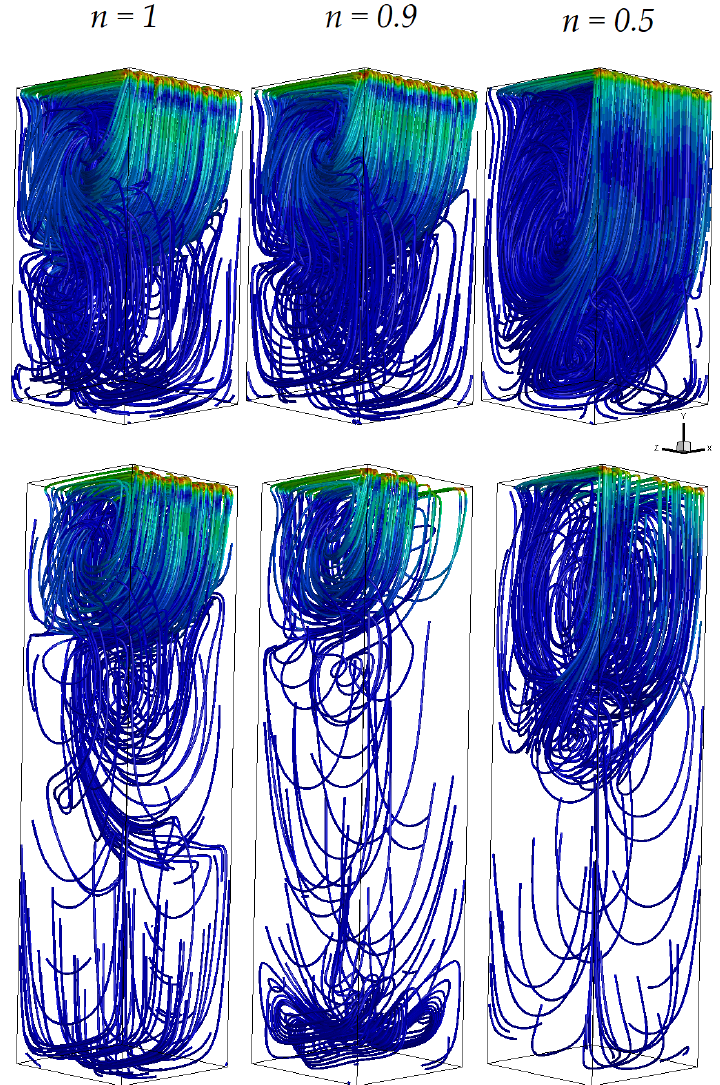
Figure 10. Flow streamlines coloured by vorticity magnitude in deeper cavities ( δ = 2, 4) for Re = 1000 as well as three different n